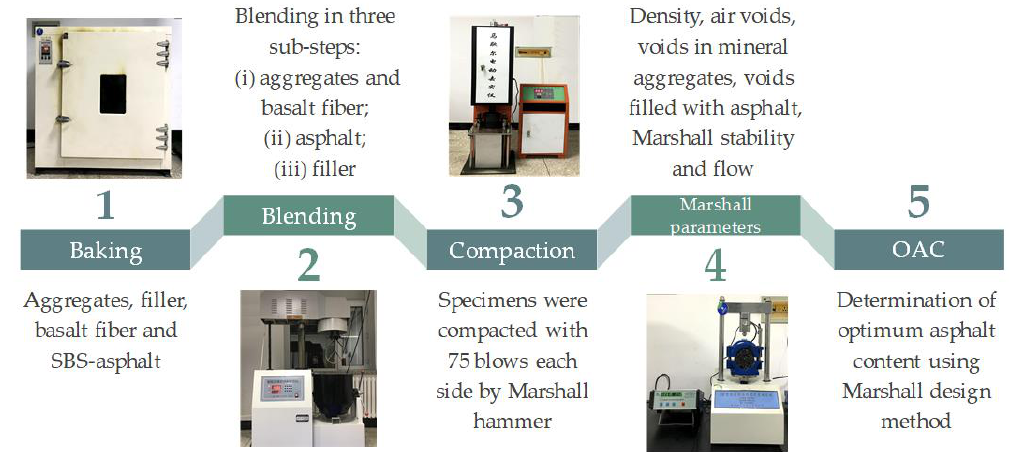
Figure 2. Preparation procedure of styrene–butadiene–styrene-stone mastic asphalt (SBS-SMA) with basalt fiber by Marshall method.